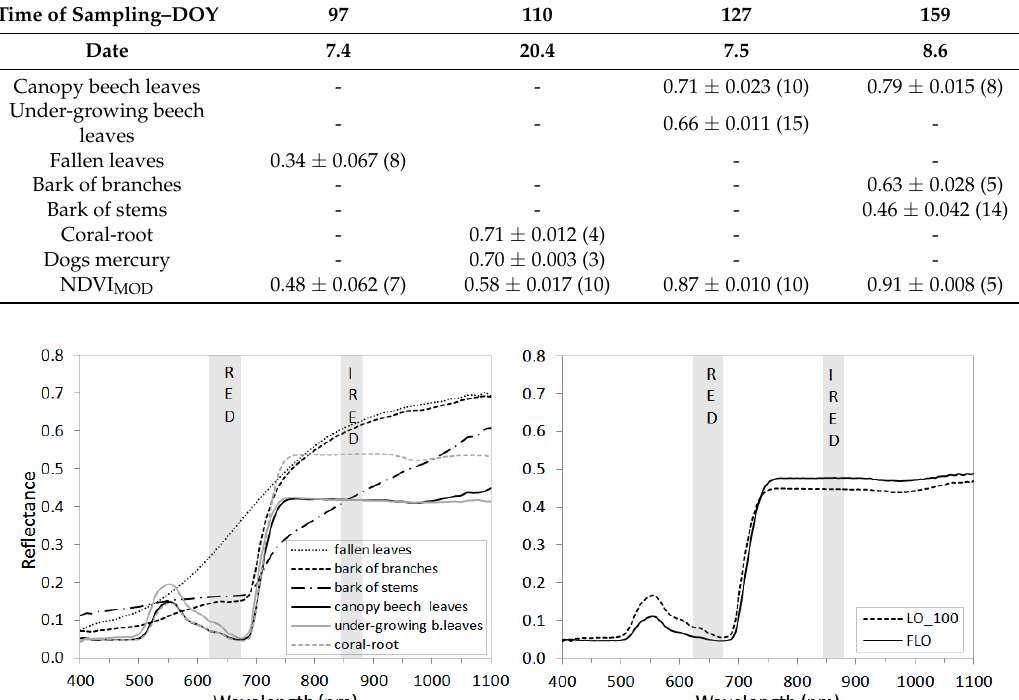
Table 3. NDVI LAB of the samples collected on the particular DOY and the satellite-based NDVI MOD derived tor the same DOY: mean ± standard deviation, and the number of samples and values respectively, in the brackets.